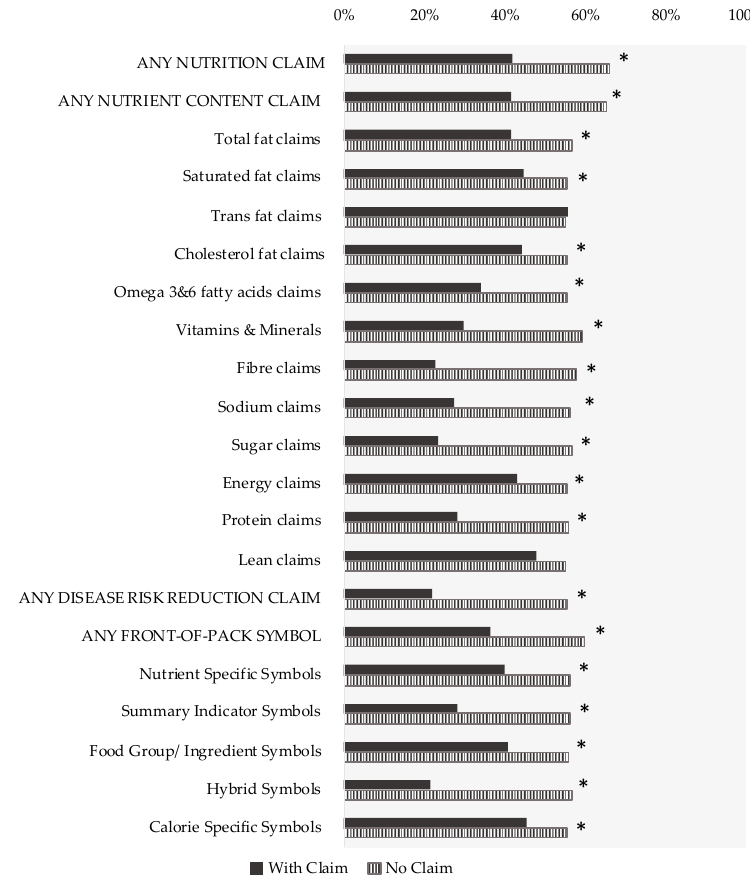
Figure 1. Overall proportion of foods and beverages with and without nutrition claims that would not be eligible to carry claims, as determined by the Food Standards Australia New Zealand Nutrient Profiling Scoring Criterion (FSANZ-NPSC), per type of claim ( n = 15,184). A product was considered not